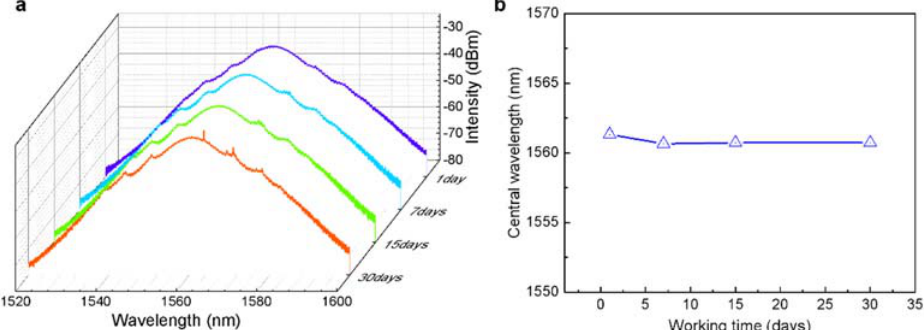
Figure 6. Long-time monitor of the GaS-based mode-locking pulse fiber laser. The performance of Figure 6. Long ‐ time monitor of the GaS ‐ based mode ‐ locking pulse fiber laser. The performance of the ( a ) spectrum and ( b ) central wavelength after 1, 7, 15, 30 the ( a ) spectrum and ( b ) central wavelength after 1, 7, 15, 30 days.